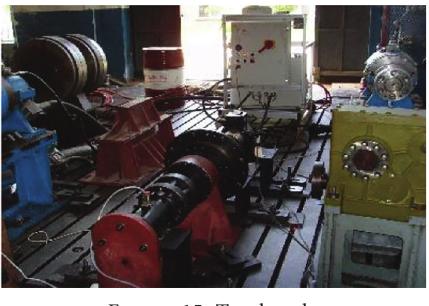
Figure 15: Test bench.